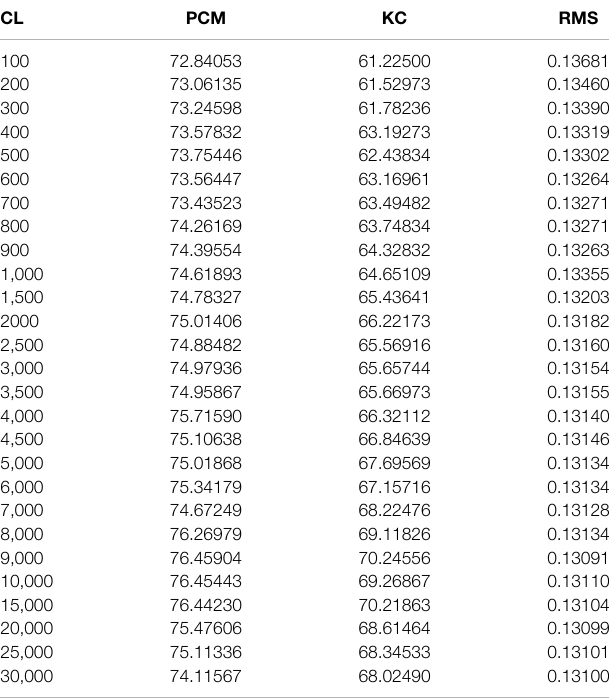
TABLE 2 | Validation result (CL, PCM, KC & RMS) in LTM model.